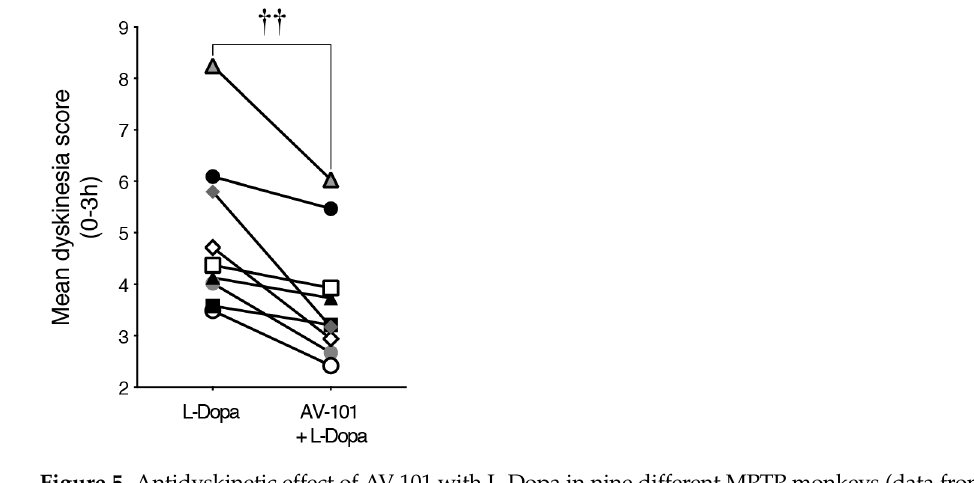
Figure 5. Antidyskinetic effect of AV-101 with L-Dopa in nine different MPTP monkeys (data from the pilot study and the main experiment) showing consistent antidyskinetic activity. †† p < 0.01 vs. L-Dopa.